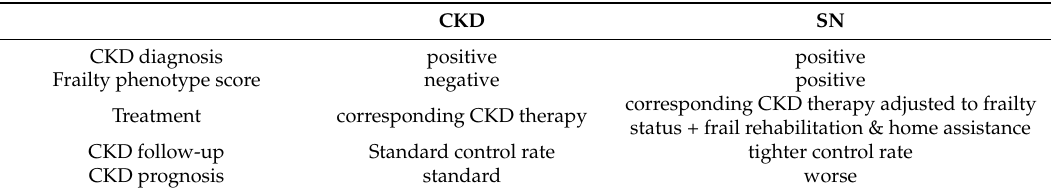
Table 2. Differences between chronic kidney disease (CKD) in fit elderly and senescent nephropathy (SN)